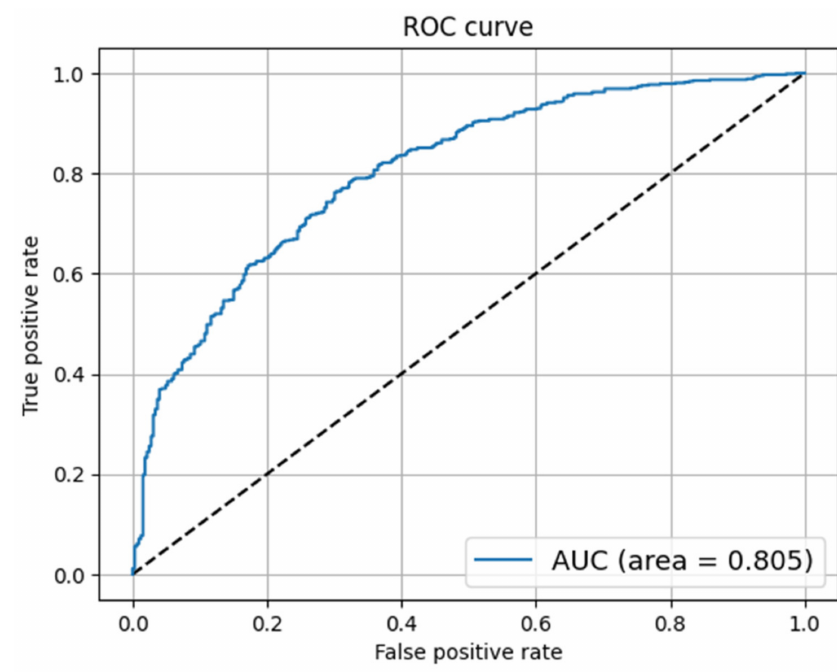
Figure 4. ROC curve of LSTM on COVID-19 Fake News